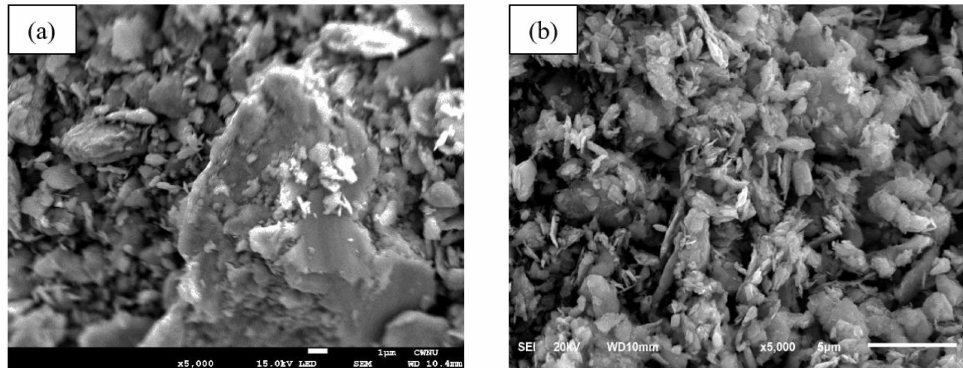
Figure 2. SEM micrograph: ( a ) SEM image for Fe 65 Ni 35 ; ( b ) SEM image of Fe 65 Mn 35